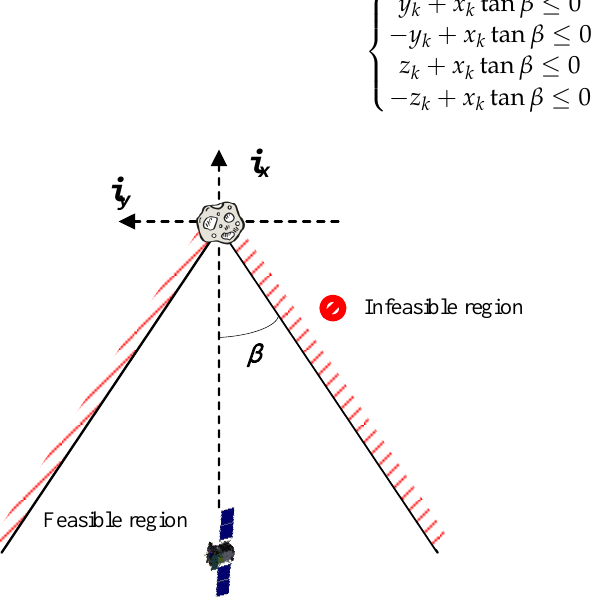
Figure 2. Visibility cone with a cone half-angle of β .